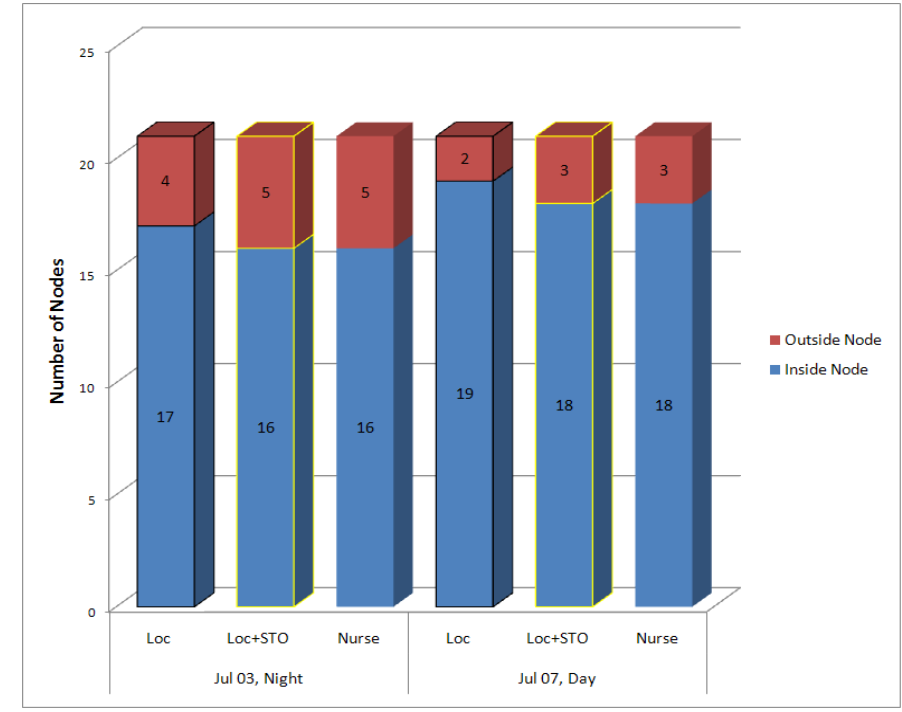
Figure 11. Failure detection of inside